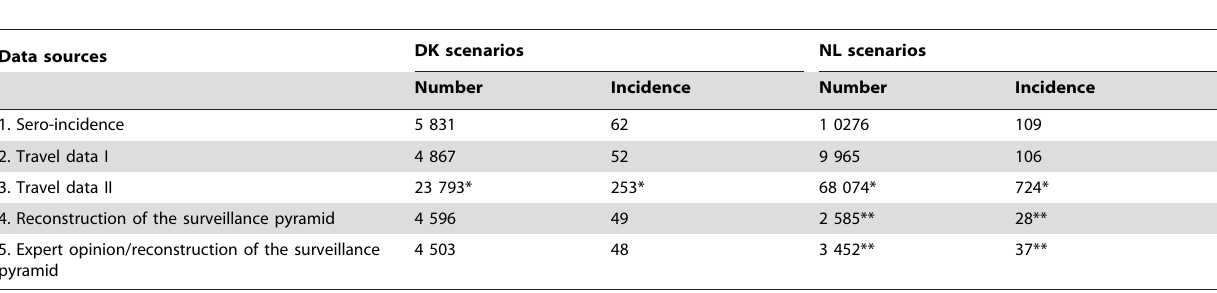
Table 2. Estimation (number and incidence [cases/100 000 inhabitants]) of the total number of reported salmonella cases in Sweden in 2010, in the different scenarios.